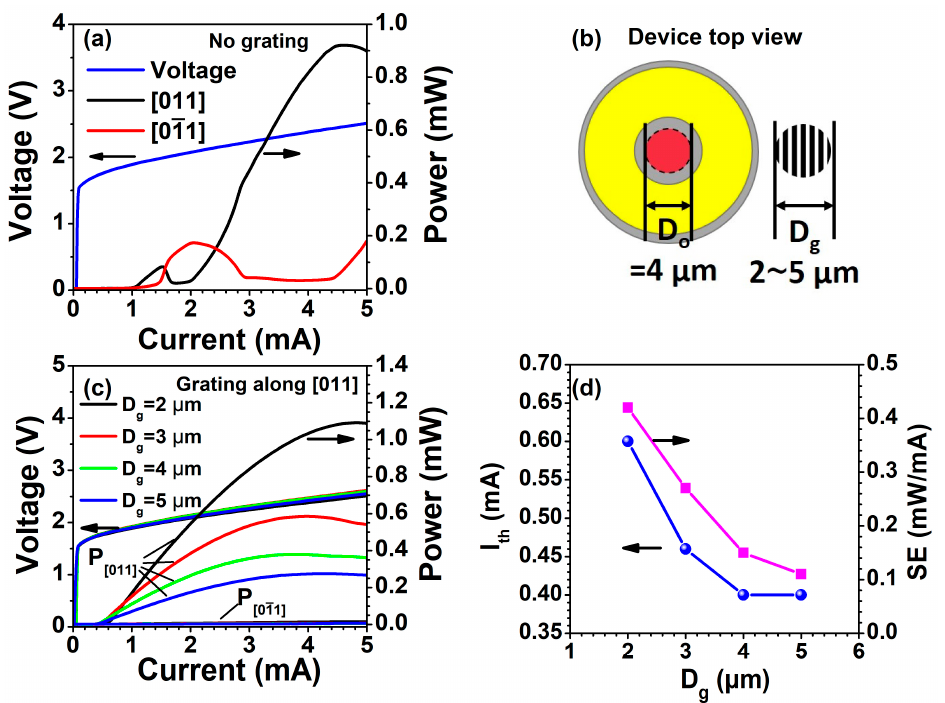
Figure 4. ( a ) Polarization-resolved light-current-voltage (L-I-V) characteristics of reference devices. ( b ) Schematic diagram of the surface grating (D g ) and oxide aperture (D o ). ( c ) Polarization-resolved L-I-V characteristics of VCSELs for different surface grating diameters with a grating period of 500 nm. ( d ) Dependence of threshold current (I th ) and slope efficiency (SE) on D g extracted from ( c ). The device was tested at room temperature